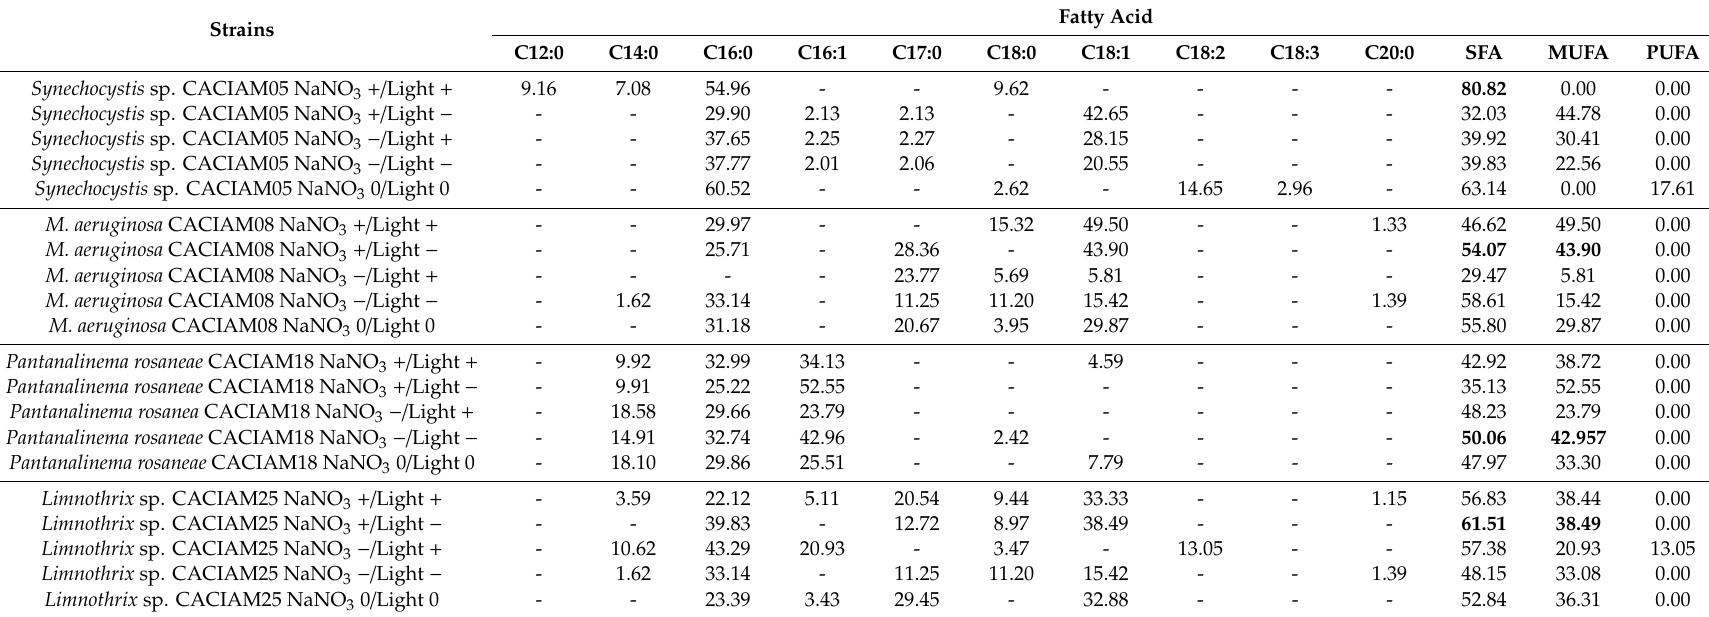
Table 2. Lipidic fatty acid profile (%) extracted from cyanobacteria